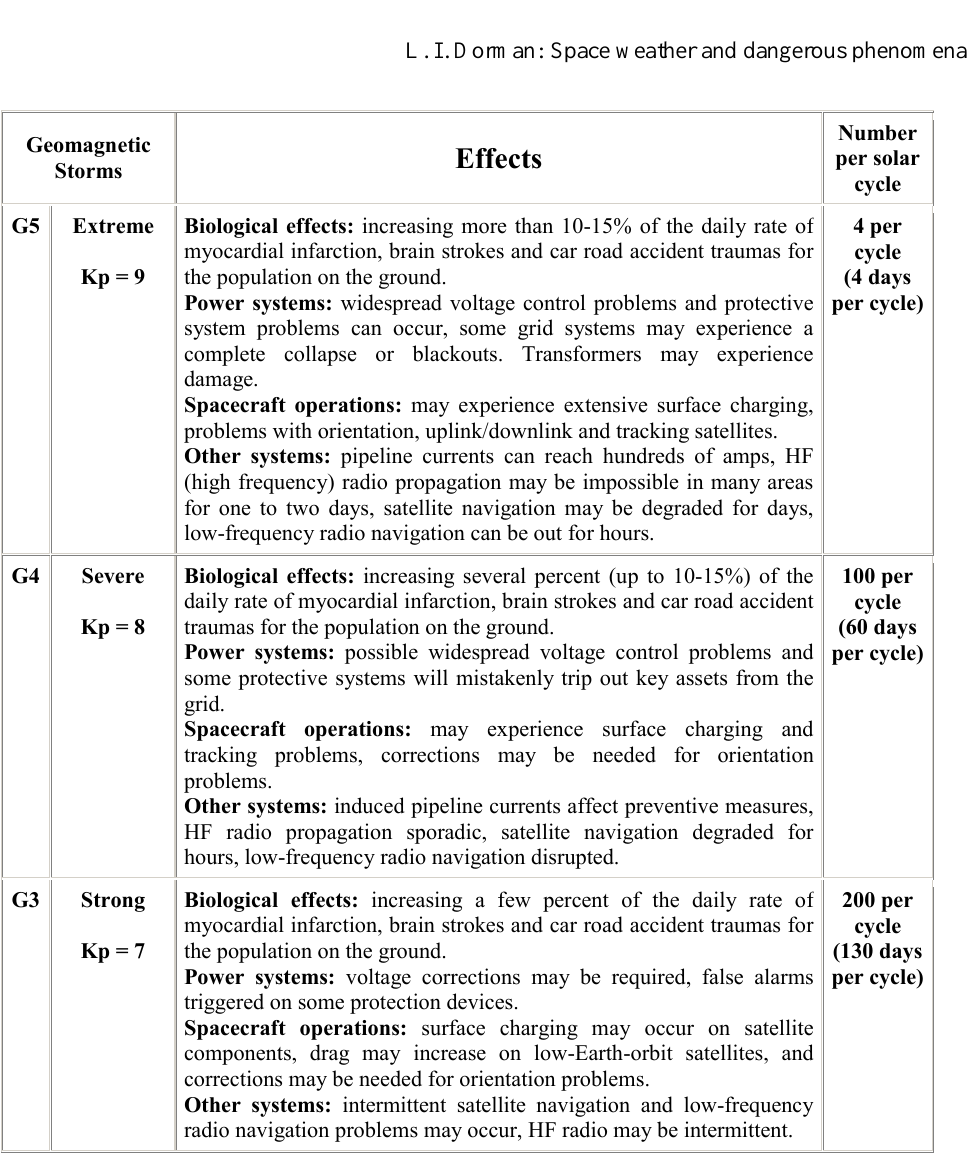
Table 1. The extended NOAA scale of geomagnetic storms’ influence on people’s health, power systems, on spacecraft operations, and on other systems (greatest three types, mostly accompanied by Forbush-decreases); in the original NOAA scale we include biological effects, according to results discussed